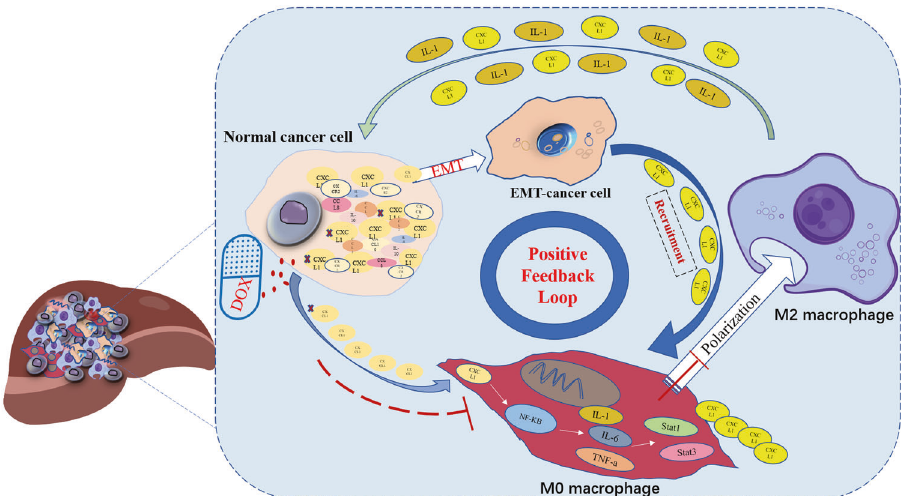
Fig. 6 A schematic model depicting the IL-1 β /CXCL1/EMT signalling loop mediates the crosstalk between HCC cells and TAMs in an in fl ammatory microenvironment. When exposed to in fl ammatory microenvironment, promoting EMT-programming in tumour cell, and up- regulates CXCL1 secretion. Moreover, M0 macrophage caused by recruitmenting more CXCL1 can be “ re-educated ” into M2 macrophage, and play pro-tumour effects. Accumulation of M2 macrophages IL-1 β /CXCL1 deepens the in fl ammatory signalling in the TME and enhances EMT in cancer cells through the NF- κ B/IL-1 β /CXCL1 axis, which all can be inhibited by DOX or anti-CXCR2 antibody in a in fl ammatory